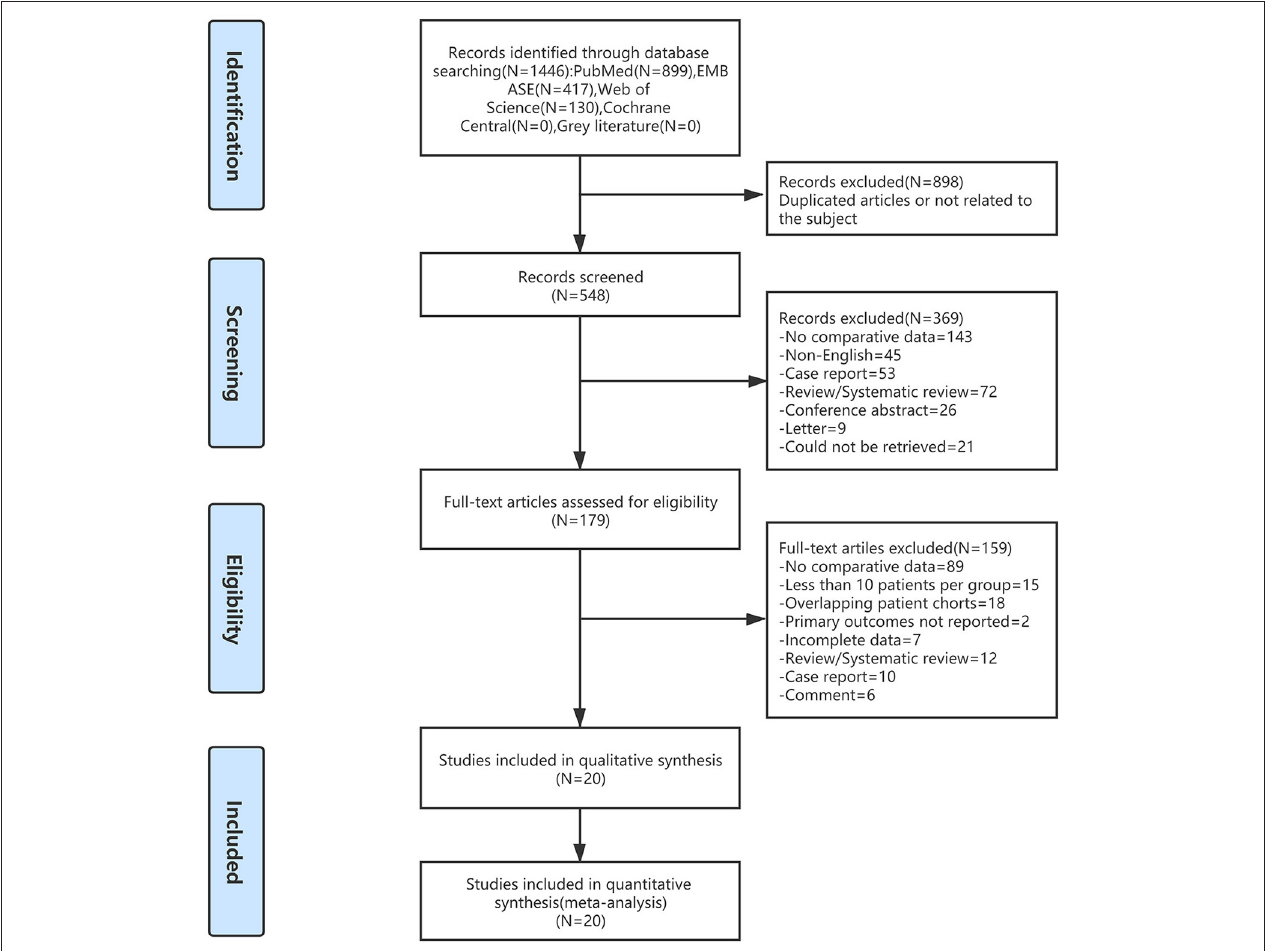
FIGURE 1 | Flow diagram of study identification and selection. LA, laparoscopic appendectomy; OA, open